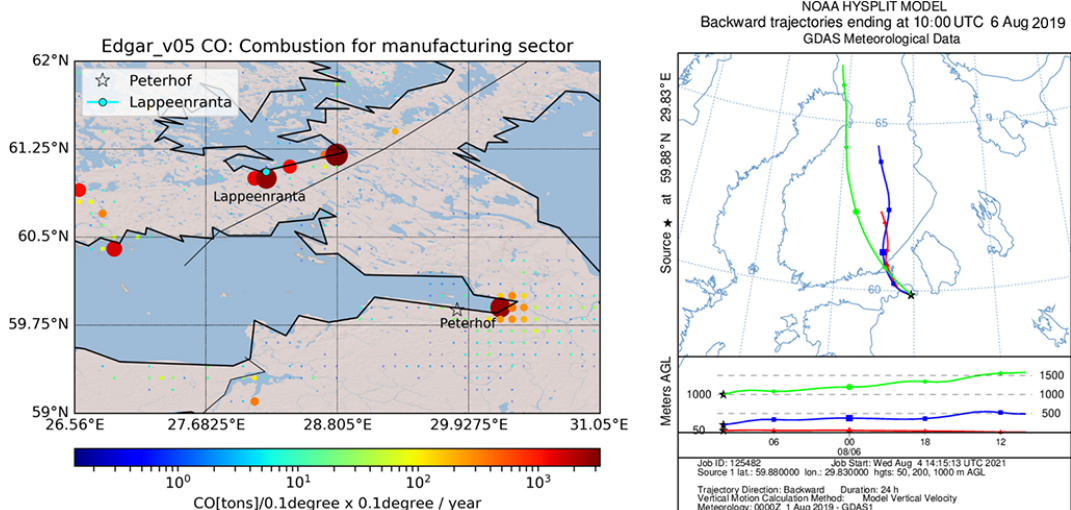
Figure A2. (a) Spatial distribution of CO emissions (tonnes per 0 . 1 ◦ × 0 . 1 ◦ yr − 1 ) from “Sector-Specific Gridmaps”: combustion for manu- facturing. Data source: EDGAR v5.0, 2015 (https://edgar.jrc.ec.europa.eu/dataset_ap50, last access: 4 August 2021); the map was generated with Python basemap toolkit by using ArcGIS from a world shaded relief model; (b) backward trajectories arriving in Peterhof on 6 August 2019, calculated by using the HYSPLIT model.